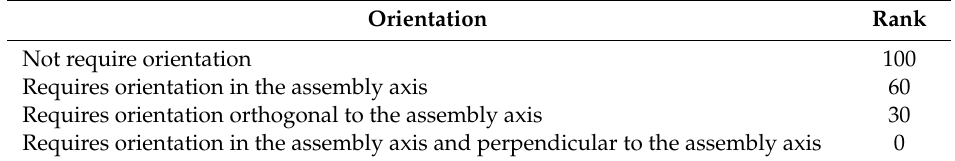
Table 7. Membership functions in tabular form of linguistic variables for